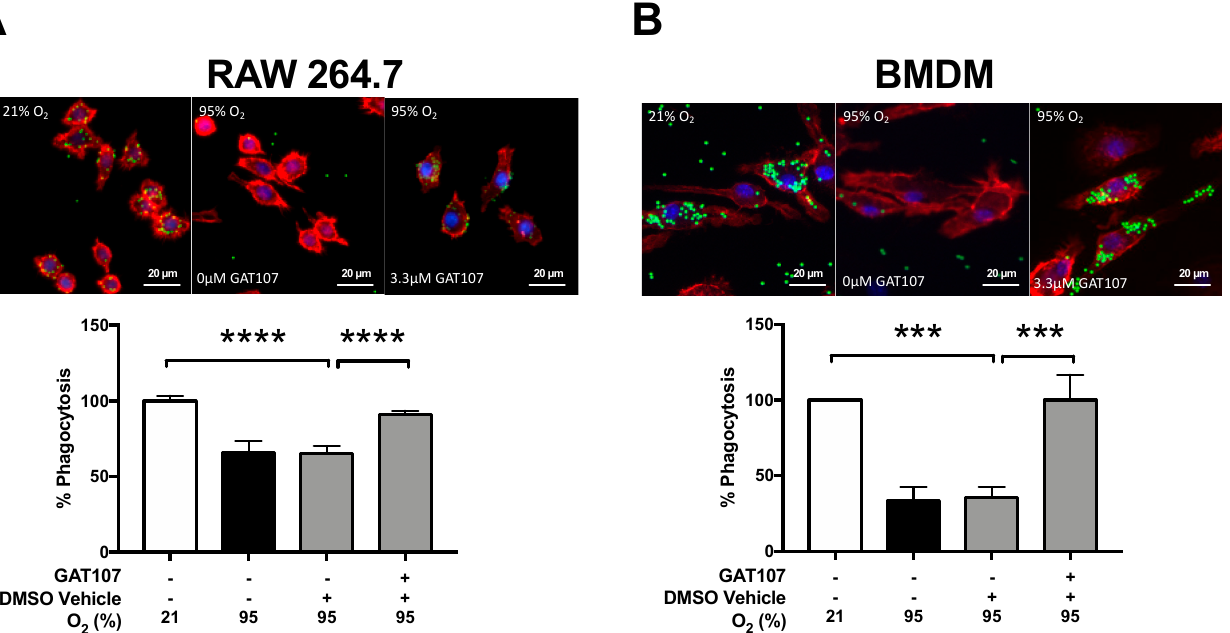
Figure 2. GAT107 restores hyperoxia-compromised macrophage phagocytic function in RAW 264.7 cells and primary macrophages. RAW 264.7 cells were either exposed to 21% O 2 (white bar) or 95% O 2 (hyperoxia) (black bar) in the presence or absence of 3.3 µ M GAT107 (grey bars). Cells were incubated with FITC-labeled minibeads for 1 h and stained to visualize the cytoskeleton and nucleus. Immunofluorescent micrographs show the phagocytosed beads (green), cytoskeleton (red), and nucleus (blue) of ( A ) RAW 264.7 cells and (B) BMDMs. The bar graphs represent the percentage of beads phagocytosed (A) RAW 264.7 and ( B ) BMDMs cells, quantified from at least 200 cells per group. Each value represents the mean ± SEM of three independent experiments for each group. Statistical differences were determined between all groups and indicated as **** p < 0.0001, *** p < 0.001 compared to the hyperoxia-exposed vehicle control group.